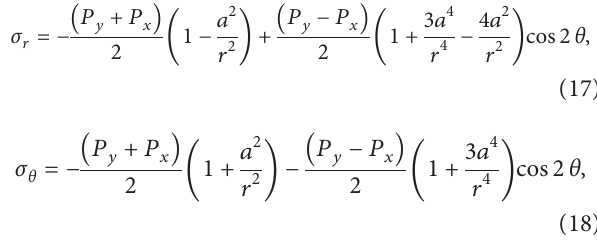
Figure 8: Stress details near the borehole during applying in situ stresses. (a) History of σ near the